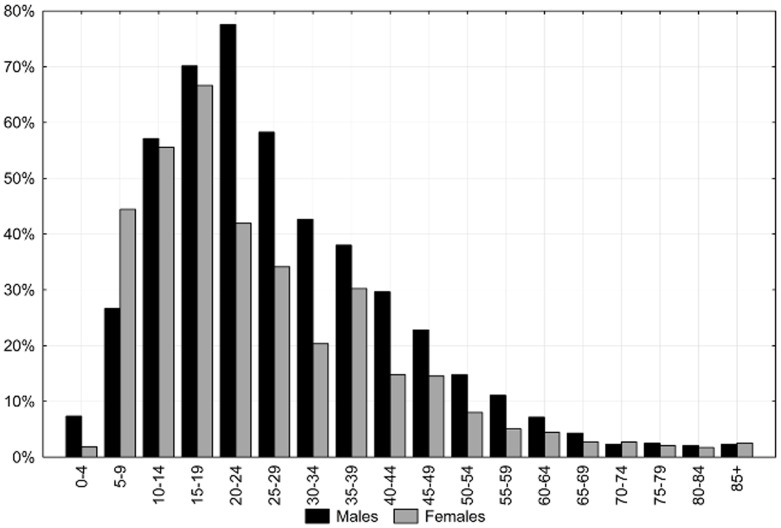
The proportion of deaths due to external causes by sex and age groups in the Lodz province in 2010.